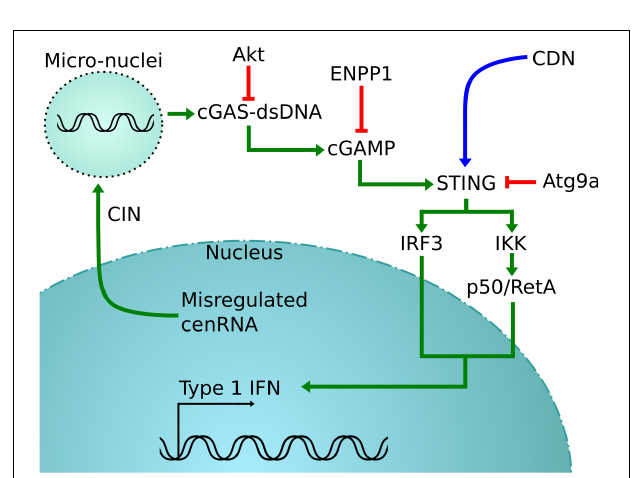
destabilize the DNA replication forks, which results in the